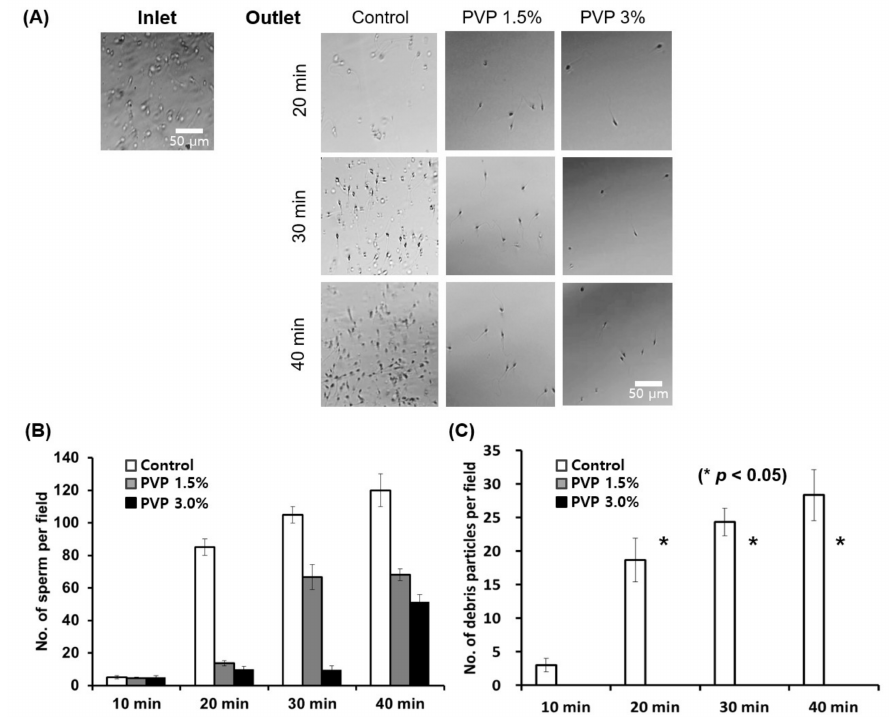
Figure 3. Quantitative analyses of sperm and debris isolated using the SSC for various PVP concen- trations (0, 1.5%, and 3%) and incubation times. ( A ) Optical microscope images of the sorted sperm using the medium (45 µ L) with PVP concentrations of 0 (Control), 1.5%, and 3%, after incubation for 20 min, 30 min, and 40 min at 37 ◦ C in 5% CO 2 . ( B ) Sperm and ( C ) debris particle counts per field for the control, PVP 1.5%, and PVP 3% media every 10 min at the outlet of the chip. All data are expressed as means ± standard error of the mean (SEM) for triplicate measurements. The significant differences are indicated by asterisks (* p < 0.05 against